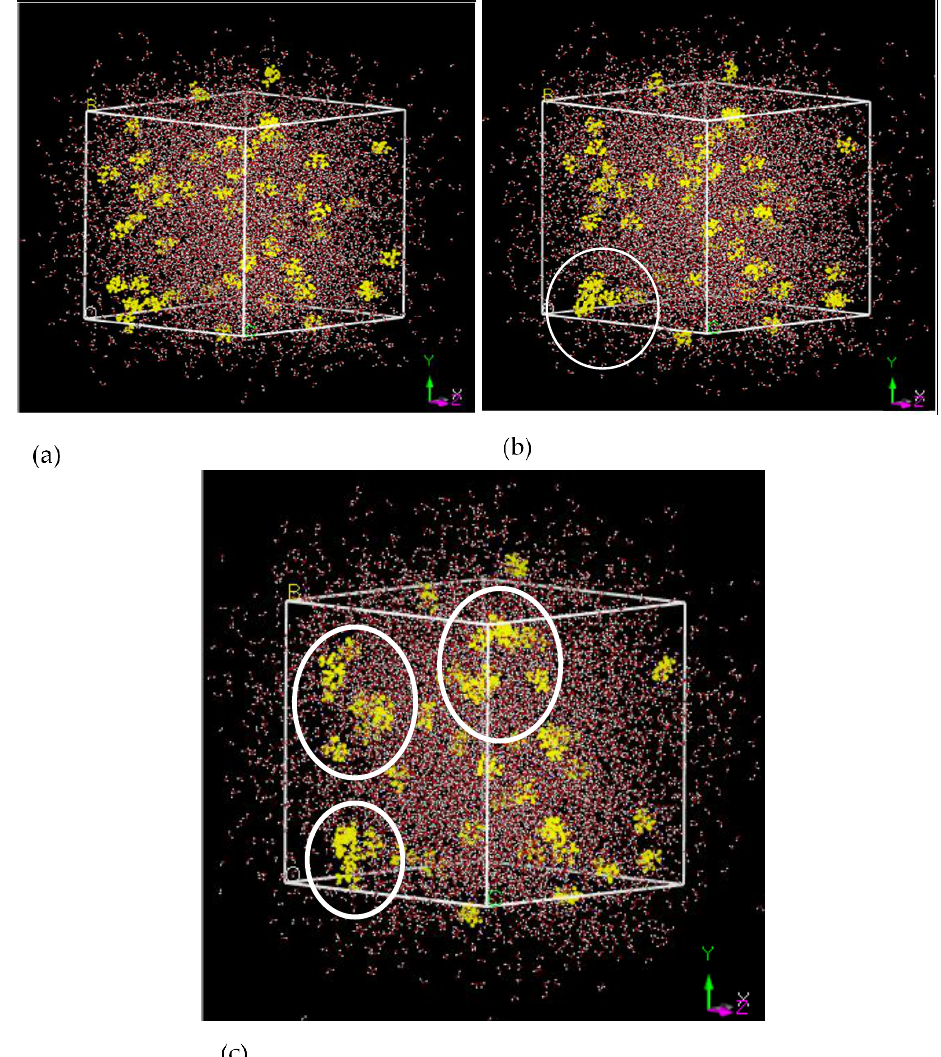
Figure 8. Snapshots of the cell showing the evolution of the simulation containing L-isoleucine and water molecules during the production run. ( a ) Cell at 0 ps, ( b ) cell at 5 ps for the 44 g/L concentration and supersaturation ratio of 1.28, and ( c ) cell at 5 ps for the solution with a 44 g/L concentration and supersaturation of 1.40 with the presence of a 5 V electric potential.